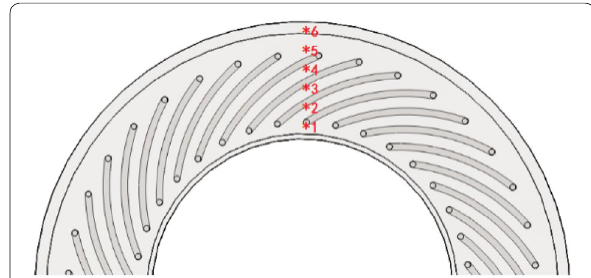
Figure 13 Measuring points of temperature sensor